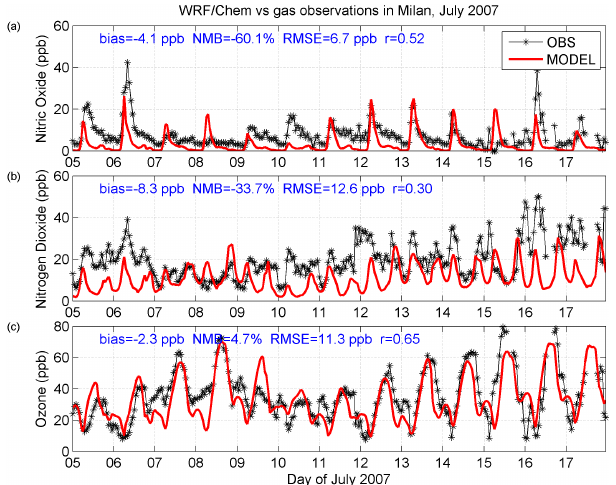
Figure 4. Same as Fig. 2 but for hourly particulate matter at ground level in Milan on 5–17 July 2007. Shown in the inset are statistical indices defined in Appendix